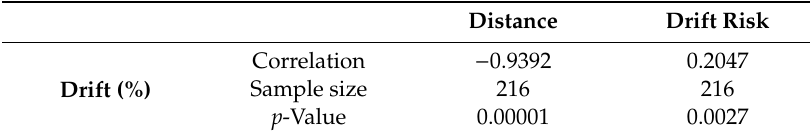
Table 5. Results of Spearman rank correlation test.